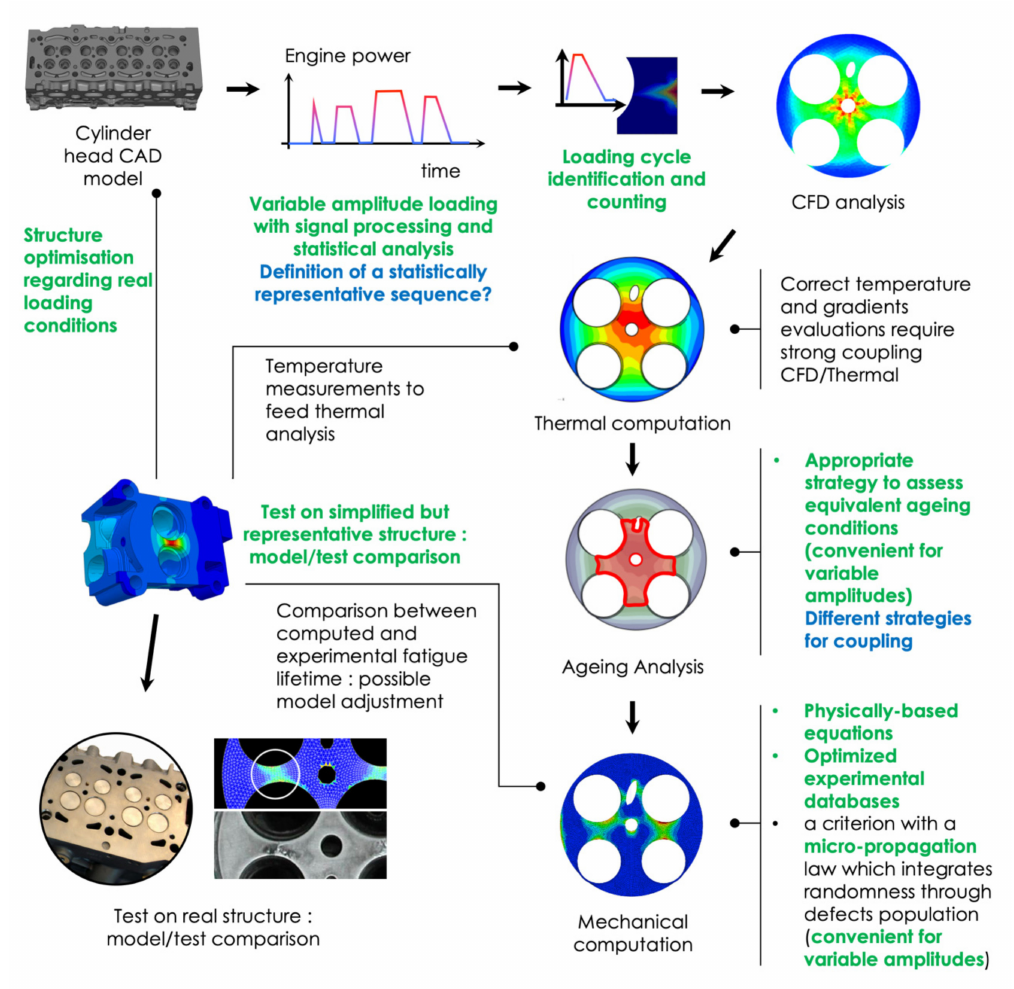
Figure 18. Summary of design protocol improvements (in green) and questions still to be answered (in blue). (CAD is for Computer Aided Design and CFD is for Computed Fluid